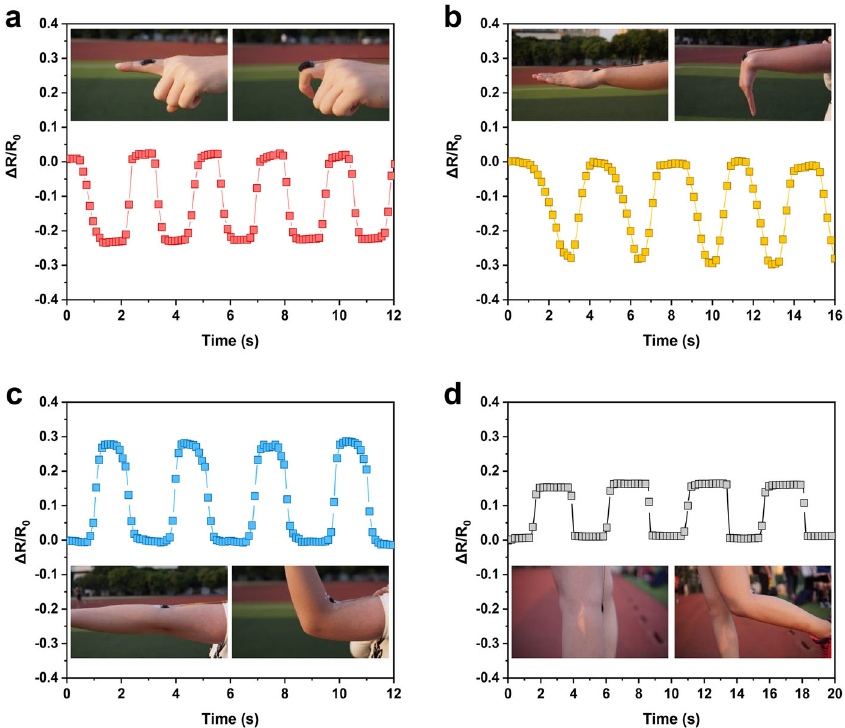
Fig. 3 H-junction bending sensor attached to joints for large-size human motion monitoring. Responses in resistance during the downward bending of ( a ) fi nger and ( b ) wrist, respectively. Responses in resistance during the upward bending of ( c ) elbow and ( d ) knee,